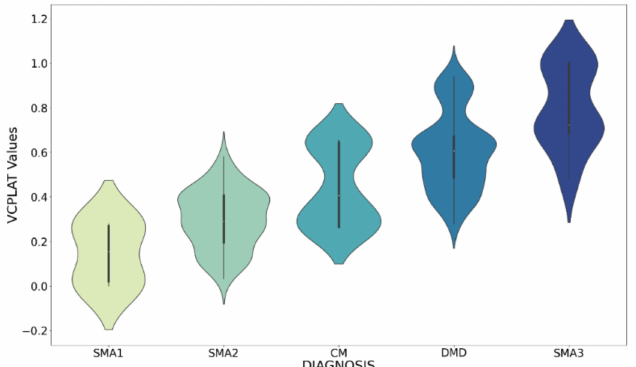
Figure 8. Violin plot of VCPLAT for different